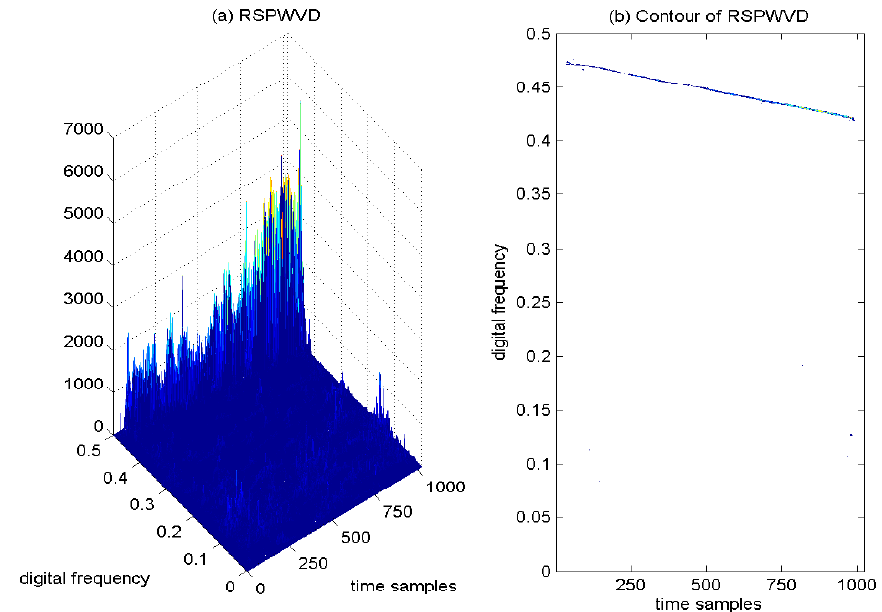
Figure 12. Joint TF analysis by adopting RSPWVD for the GPS L1 signal with sweep interference. C/N = 46 dB-Hz, JNR = − 1 0